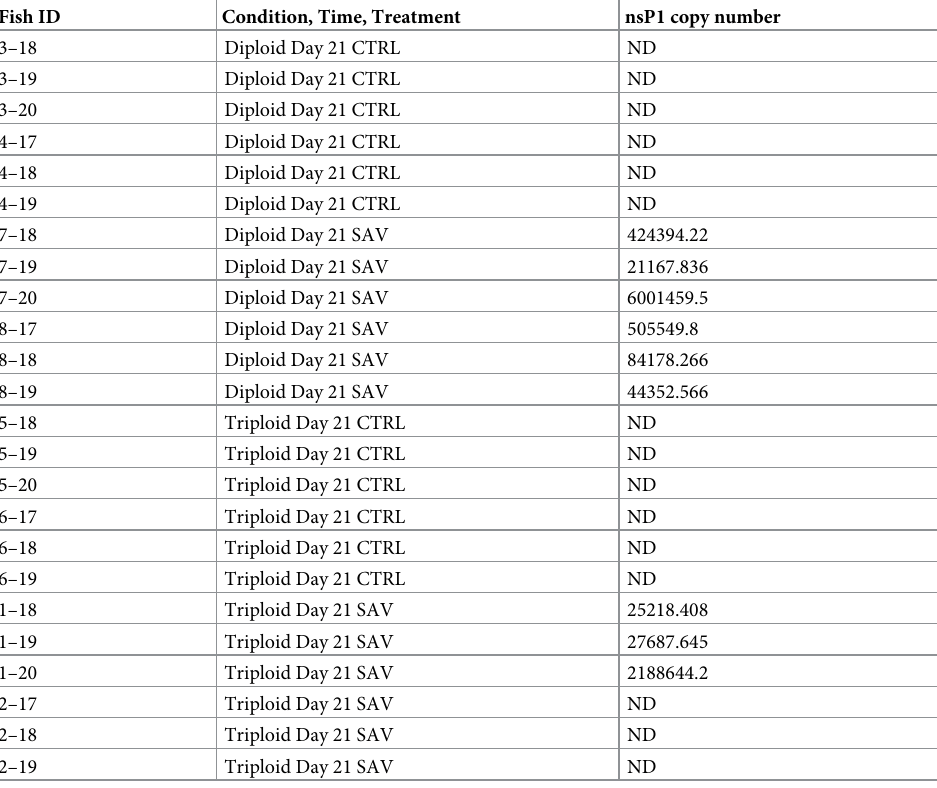
Table 3. SAV3 levels in heart tissue samples from fish used in this study. SAV3 titers were estimated using qPCR on nsP1 gene. ND—not detected (below detection limit). Fish